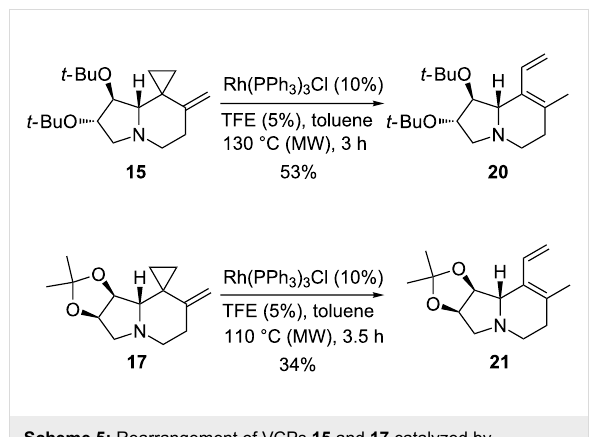
Scheme 5: Rearrangement of VCPs 15 and 17 catalyzed by Rh(PPh 3 ) 3 Cl.